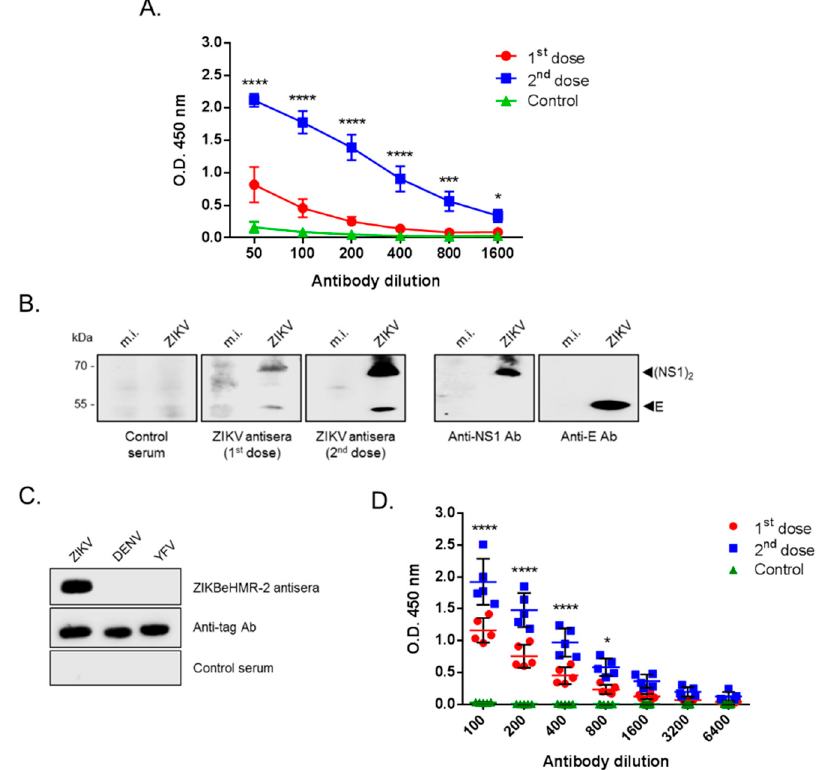
Figure 3. Reactivity of mouse anti-ZIKBeHMR-2 immune sera on ZIKV antigens. In ( A ), indirect ELISA on pooled immune sera ( n = 5) of adult BALB / c mice that received one (1st dose) or two (2nd dose) doses of ZIKBeHMR-2 (5 log PFU) with an interval of 6 weeks. Inactivated ZIKBeHMR-2 virus particles served as capture viral antigen. Data are presented as mean ± SEM of three independent experiments. Statistical significance between 1st dose and 2nd dose values is indicated. In ( B ), Vero cells were infected during 24 h with ZIKBeHMR-2 (ZIKV) at m.o.i. of 1 or mock-infected (m.i.) and then lysed with RIPA lysis bu ff er. Immunoblot assay on cell lysates was performed with pooled immune sera of mice (ZIKV antisera) that received one or two doses of 5 log PFU of ZIKBeHMR-2 with an interval of 6 weeks. Sera of mice inoculated with vehicle were used as a control (control serum). The expression of E was verified with anti-E mAb 4G2 (anti-E Ab). The rat anti-ZIKV NS1 immune serum (anti-NS1 Ab) detected the NS1 dimer [(NS1) 2 ]. In ( C ), equal amount (500 ng) of highly purified rEDIII proteins from ZIKV, DENV and YFV was analyzed by immunoblotting with pooled anti-ZIKBeHMR-2 immune sera (ZIKBeHMR-2 antisera) at dilution 1:500. Pooled sera of mice that received vehicle PBS / FBS (control serum) were used as control. Expression of His-tagged rEDIII proteins was detected using anti-HIS tag mAb (anti-tag Ab). In ( D ), individual immune serum of BALB / c mice ( n = 5) that received one (1st dose) or two doses (2nd dose) of 5 log PFU of ZIKBeHMR-2 with an interval of 6 weeks or vehicle PBS / FBS (control) were assayed for the detection of antibodies against ZIKV EDIII protein by indirect ELISA using recombinant ZIKV.rEDIII as capture antigen. Statistical significance between the first dose and second dose values is indicated.